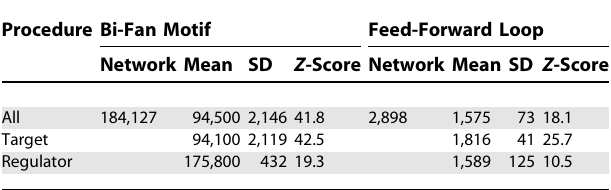
Table 1. Summary of Statistical Significance of Network Motifs under Several Randomization Procedures Procedure Bi-Fan Motif Feed-Forward